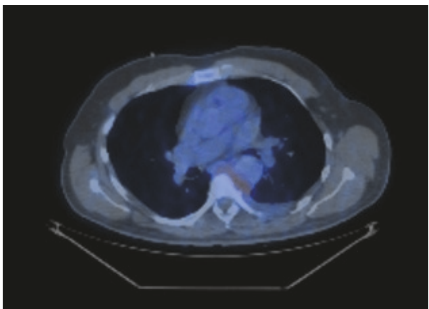
Figure 3: PET scan following four courses of chemotherapy still demonstrating metabolic activity.